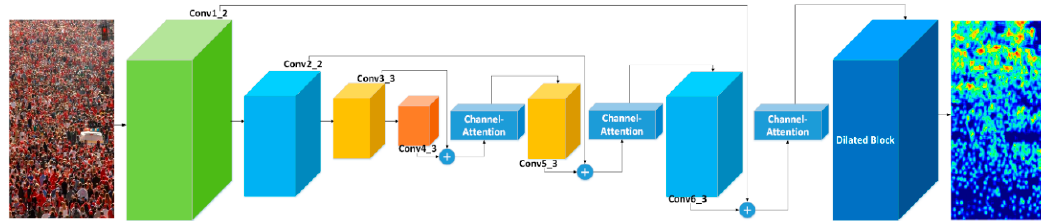
Figure 1. The architecture of our FDCNet (frontend-backend fusion dilated network through channel-attention mechanism) model. The input of the network is the original crowd image, which is fed into different convolutional groups. Conv1_2 et al. represent the feature maps output from different levels. The feature maps from the low level and high level are concatenated, then they are sent to the channel-attention blocks. In the end, the feature maps are fed into the dilated blocks, followed the output density map.